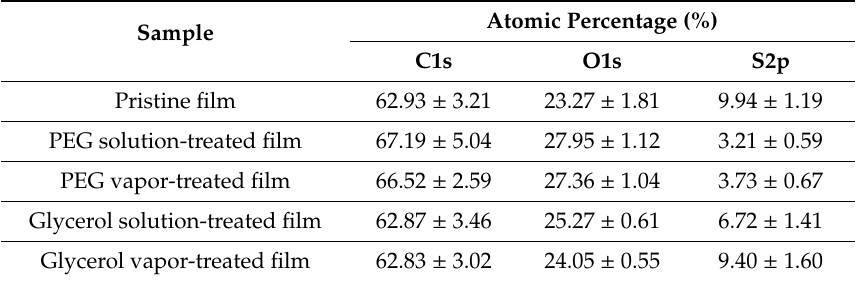
Figure 1. ( a ) Formation of sulfonic ester (covalent linkage) in intra and / or inter PSS. ( b ) FTIR spectra of neat PSS, glycerol vapor0treated PSS, and glycerol. Table 1. Atomic percentage of different elements from XPS results on Pristine, PEG solution-treated, PEG vapor-treated, glycerol solution-treated, and glycerol vapor-treated films.